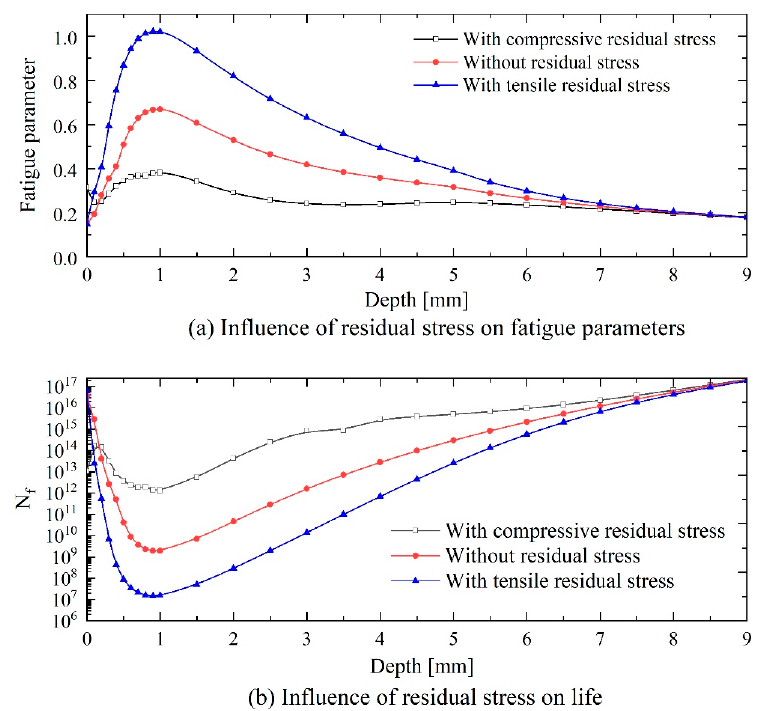
Figure 22. Influence of residual stress on fatigue parameters and life, ( a ) influence of residual stress on fatigue parameters, ( b ) influence of residual stress on life.